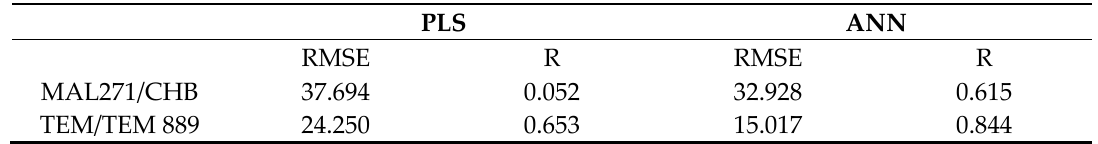
Figure 4. ANN predictions of the different wine concentrations, left figure for the white wine samples and right figure for the red wine samples. Table 1. Root mean square error (RMSE) and regression coefficients of the prediction of the ANN and PLS, for the cited wine